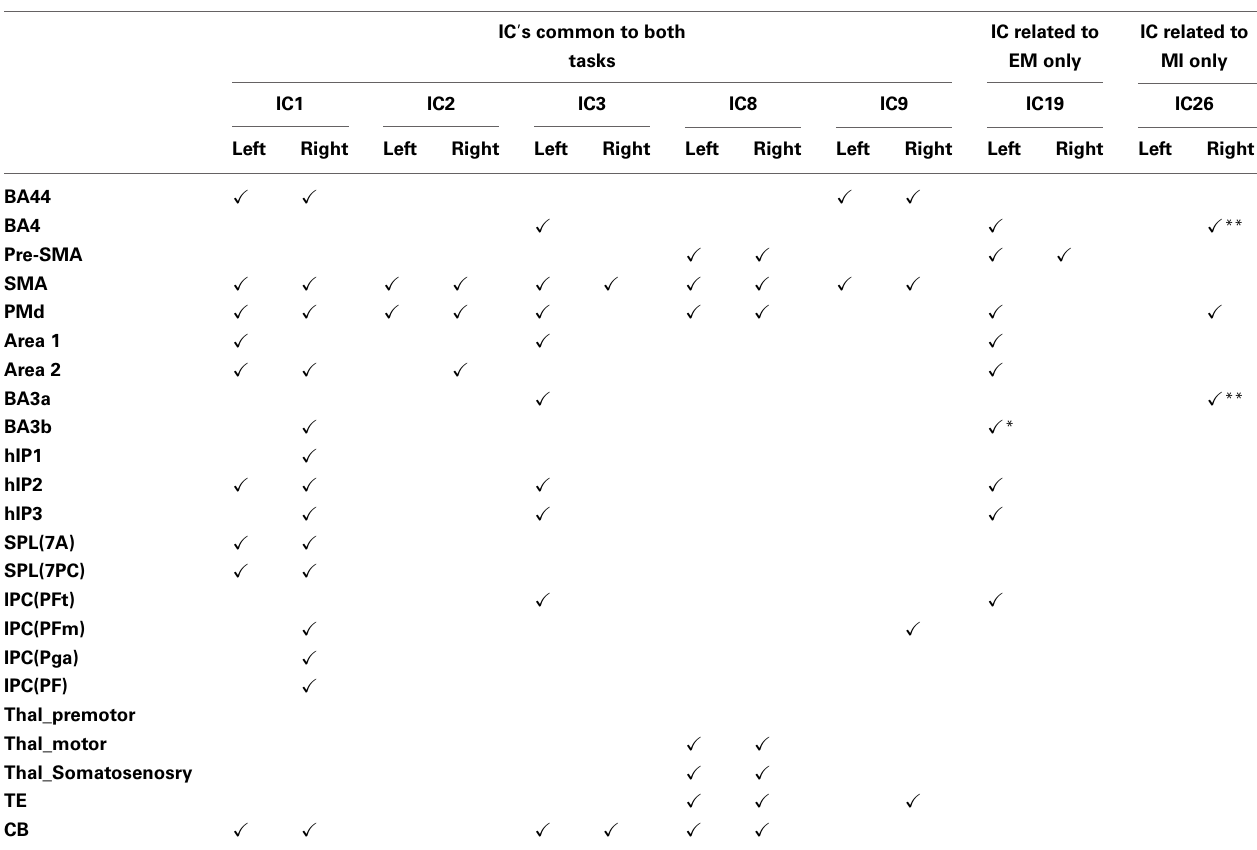
Table 1 | Regions activated in each independent component. IC ’ s common to both IC related to IC related to tasks EM only MI